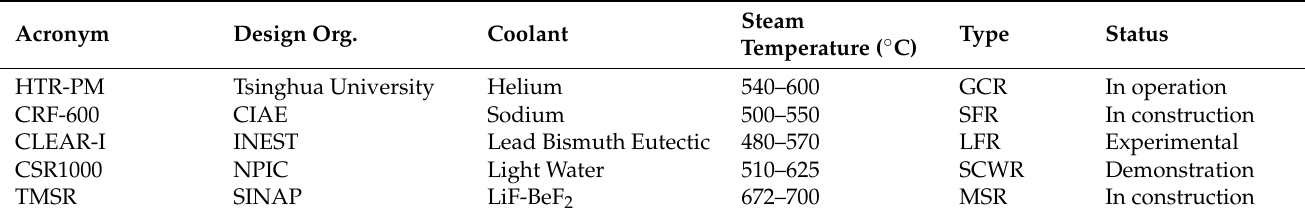
Table 4. Advanced reactors under development in